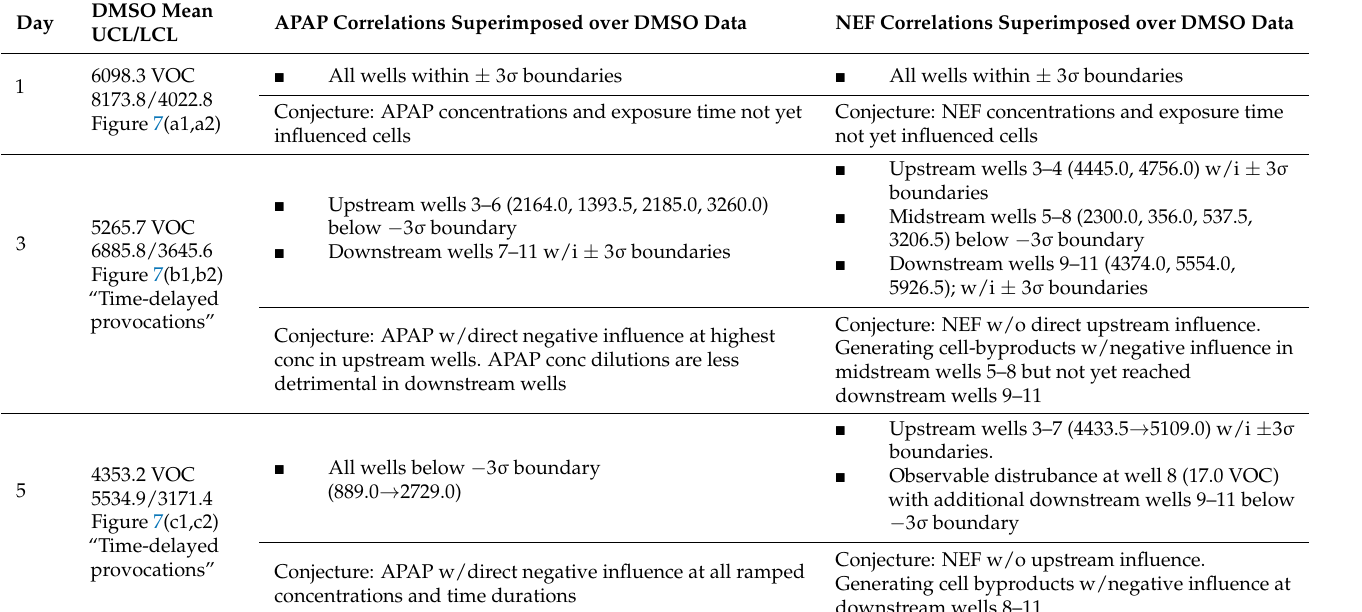
Table 3. Trending VOC outcomes from direct parent compound and indirect cell